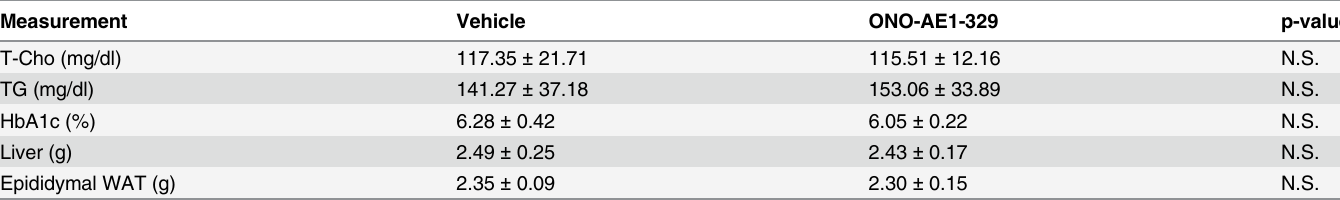
Table 1. Effects of EP4 agonist on metabolic